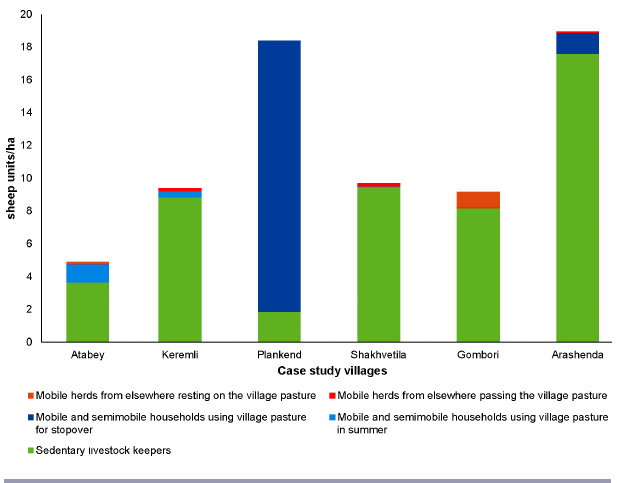
Fig. 4 . Grazing pressure on pastures in the case study villages by different stakeholder groups.